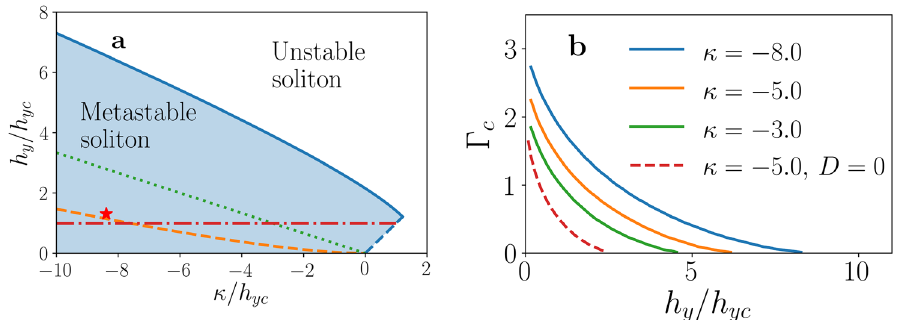
Figure 2. Limits of stability of the chiral soliton. ( a ) Stability diagram of the chiral soliton for D > 0 , as a function of anisotropy and applied field. The blue continuous line corresponds to the stability limit for χ = + 1 , with the dashed blue line indicating the onset of instability of the whole system against tilting towards the ˆ z direction. The orange dashed line corresponds to the stability limit for χ = − 1 case. The green dotted line is the stability limit for D = 0 and χ = ± 1 . Below the red dash-dotted line the FM state is itself metastable, the ground state being a CSL. The red star indicates the parameter values used to perform the numerical simulations. ( b ) The critical Ŵ c value, proportional to the critical current density, as a function of h y / h yc for χ = + 1 and for several values of κ , as indicated. The red dashed line corresponds to D = 0